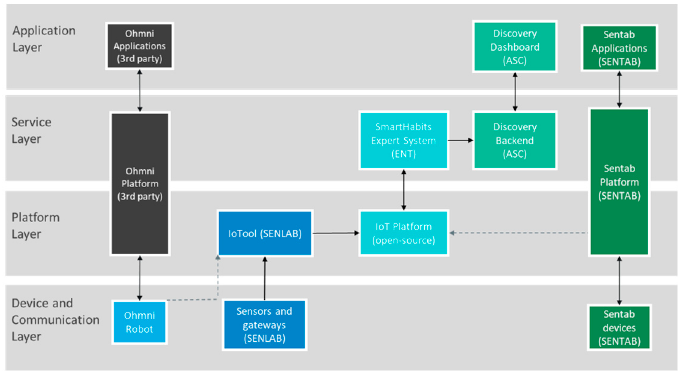
Figure 3. High-level system view of the Italian pilot.